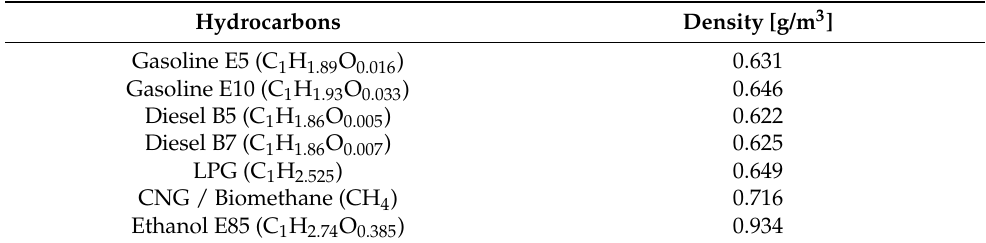
Table 1. Total hydrocarbon density (g/dm 3 ) under the reference conditions of 273.15 K and 1013.25 hPa [1,3].